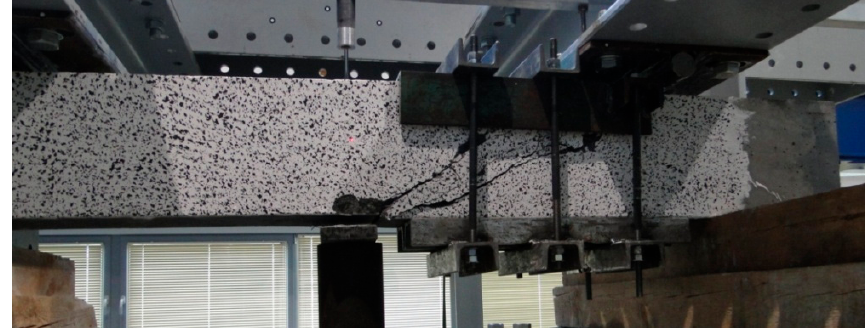
Figure 8. Beam reinforced with steel corset after the first testing stage.